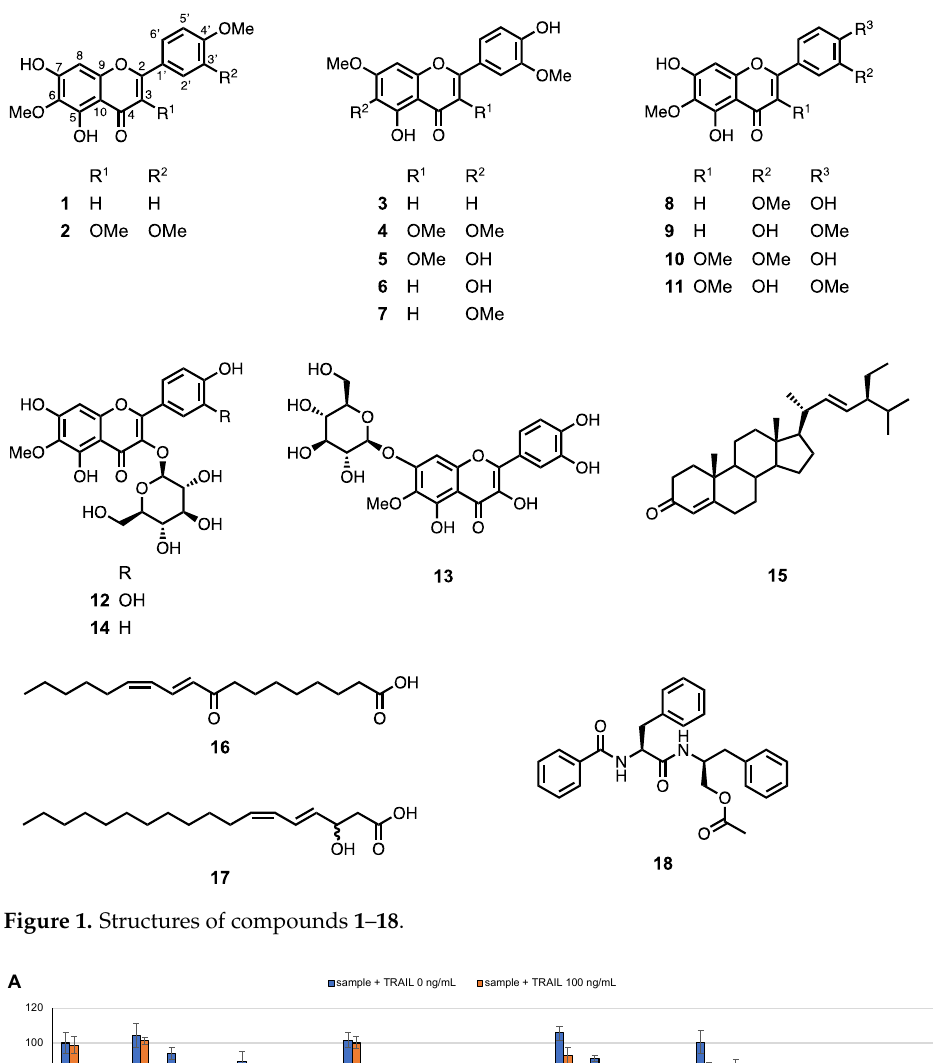
Figure 1. Structures of compounds 1 – 18 .